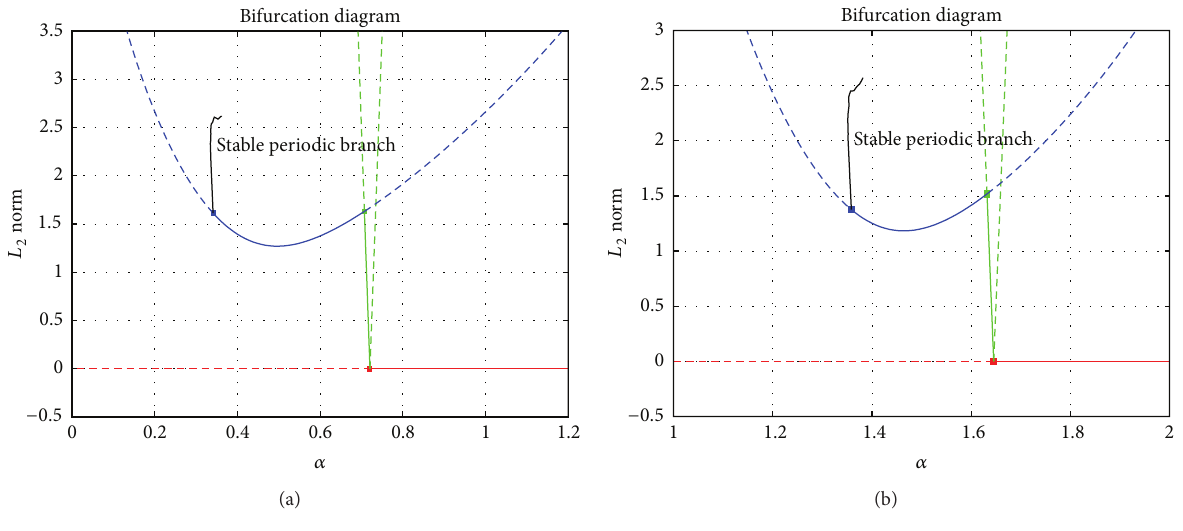
Figure 2: Case 1. (a) 𝑚 = 2 , (b) 𝑚 = 5